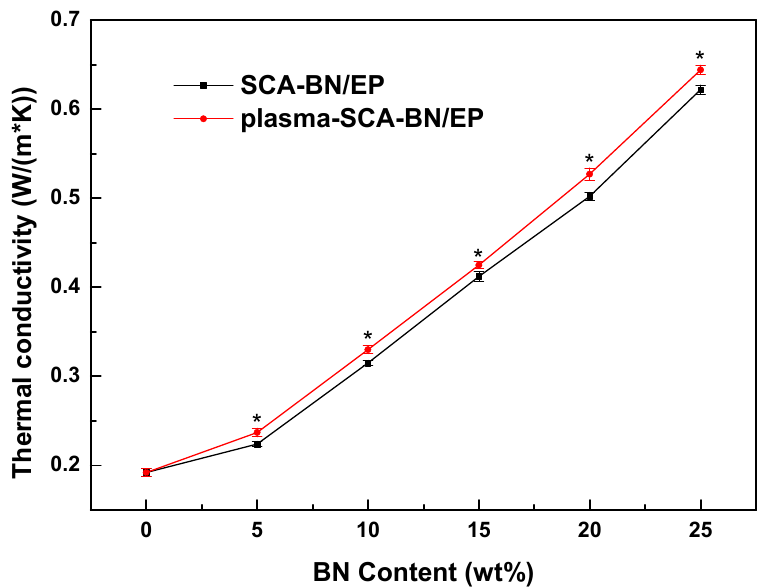
Figure 15. Thermal conductivity of BN / EP nanocomposites with SCA treated BNNSs (SCA-BN / EP) and plasma and SCA treated BNNSs (plasma-SCA-BN / EP) at di ff erent contents. * p < 0.05.